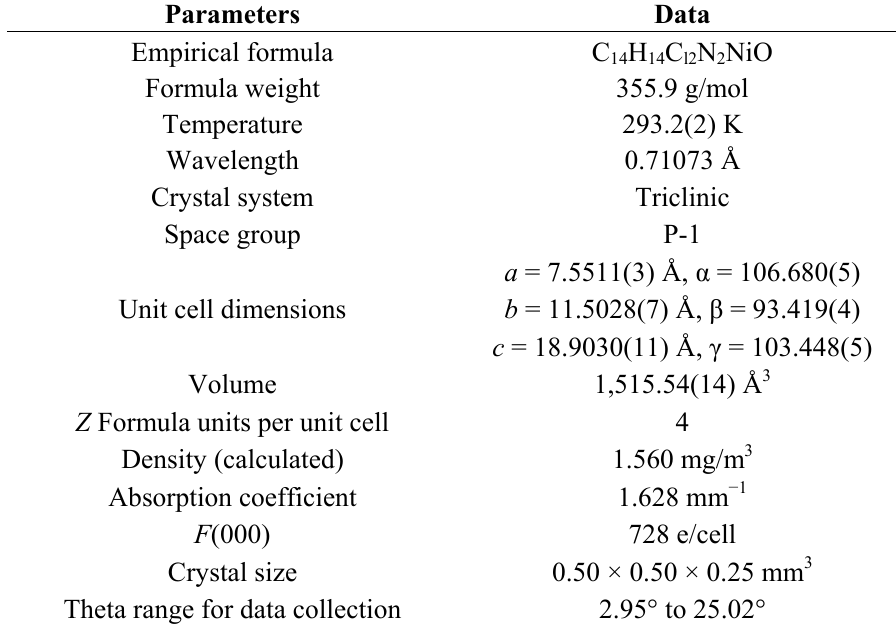
Table 2. Crystal data and structure refinement for the